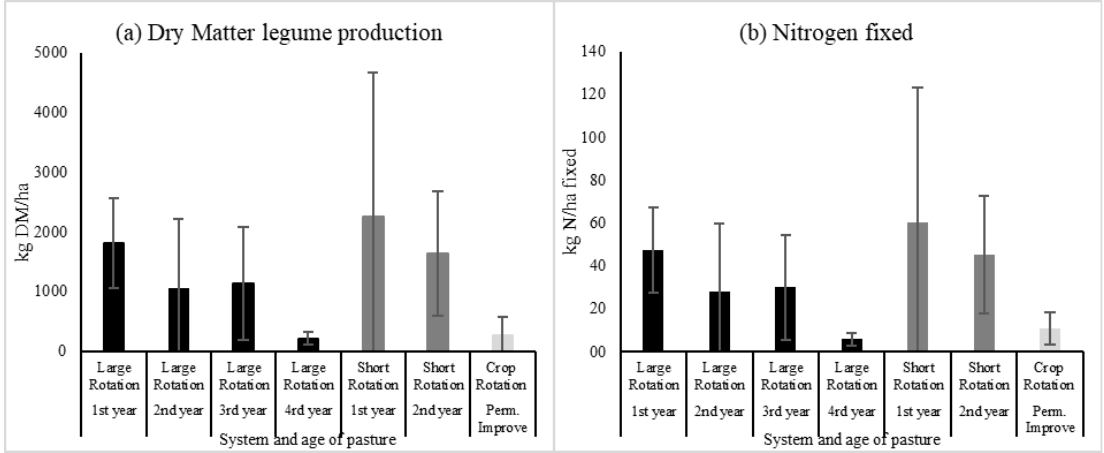
Figure 5. Dry-matter production of legumes ( a ) and Nitrogen fixed ( b ) by age of pasture in the ‘Palo a Pique pasture – crops rotations long-term experiment in Treinta y Tres, Uruguay. Table 7. Level (kg DM/ha) and type of supplementation in each Pasture Crop Rotation in ‘Palo a Pique’ long-term experiment in Treinta y Tres, Uruguay.